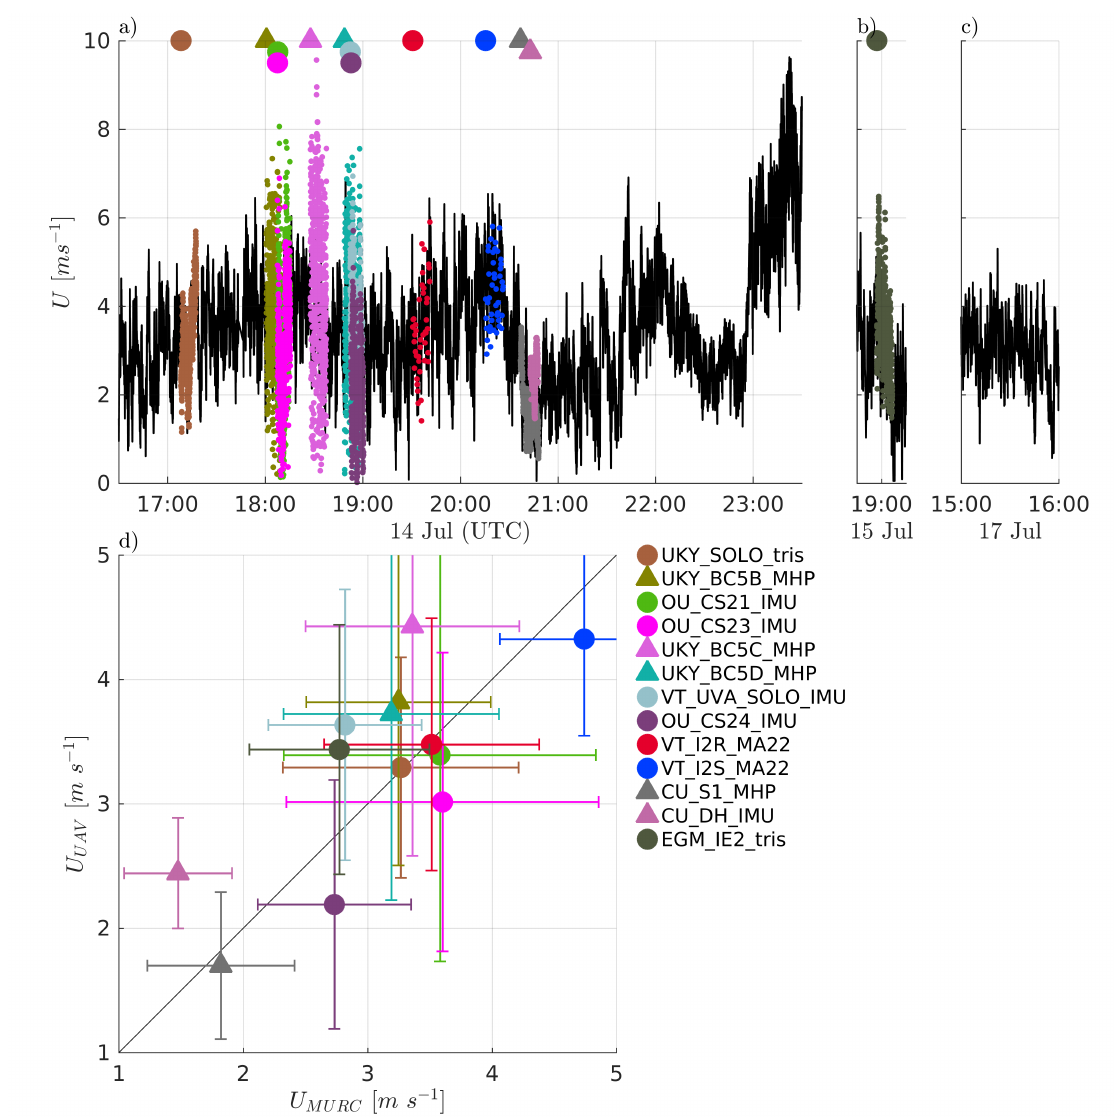
Figure 7. Time series of wind speed measurements during July 14 ( a ), 15 ( b ), and 17 ( c ) and differences to MURC reference measurements ( d ). The colors and markers follow the same scheme as in Figure 4, although without indication of the sensor setup (white